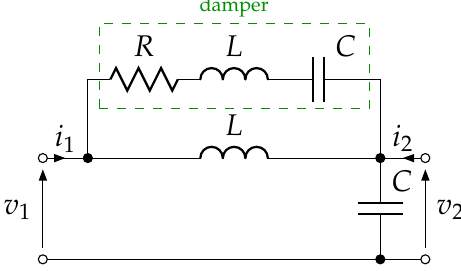
Figure 6. Proposed line/load filter with resonant resistive damper.